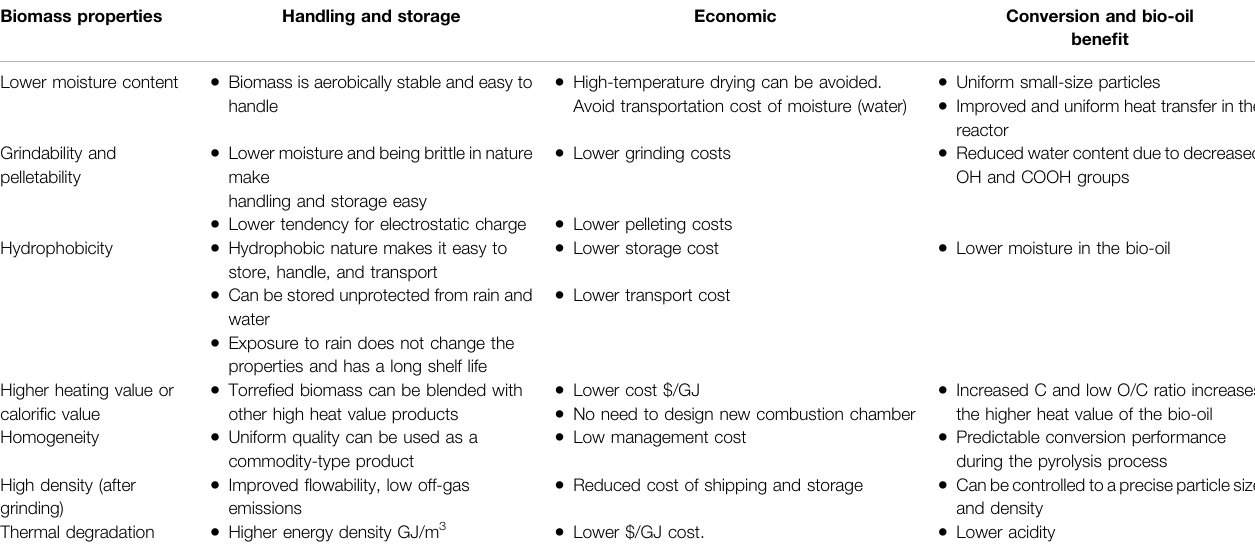
TABLE 1 | Bene fi ts of torrefaction on biomass properties, handling, and storage, economics, and bio-oil quality (Ghiasi, 2019). Biomass